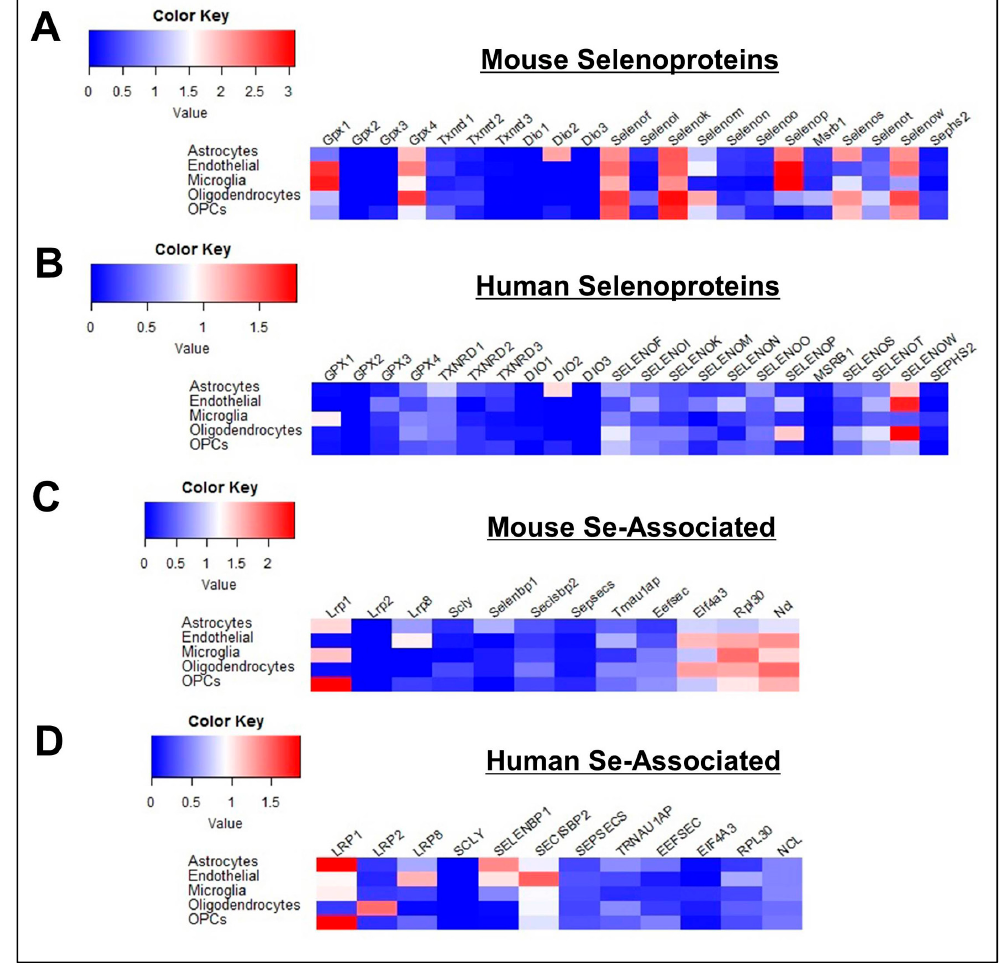
Figure 2. Profile of Se-Related Transcriptome in Non-Neuronal Cells. ( A , B ) Heatmaps detailing expression of mouse ( A ) and human ( B ) selenoprotein genes in astrocytes, endothelial cells, microglia, oligodendrocytes, oligodendrocyte precursor cells (OPCs). ( C , D ) Corresponding heatmaps of mouse ( C ) and human ( D ) Se-associated